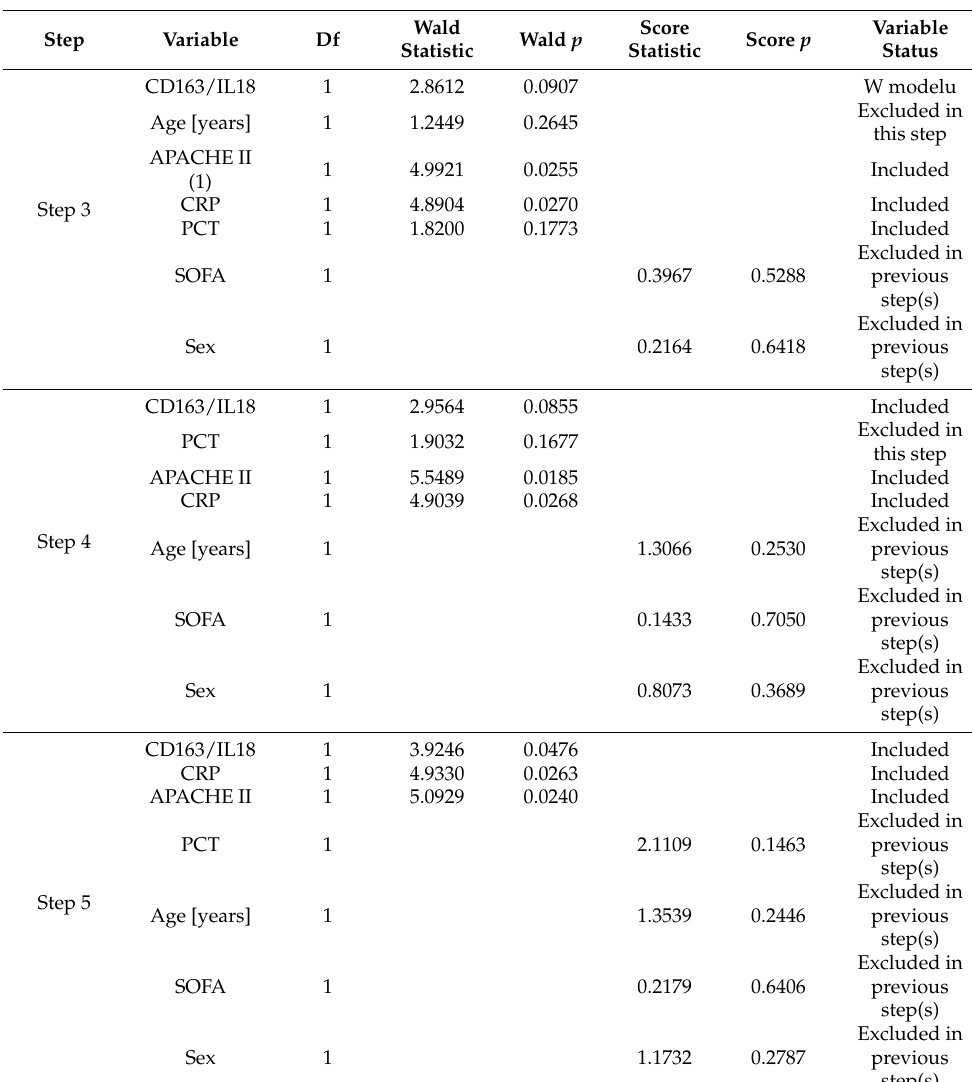
Table A3. Cont. DERIVATION OF MODEL 1 (Table 4: MODEL 1)